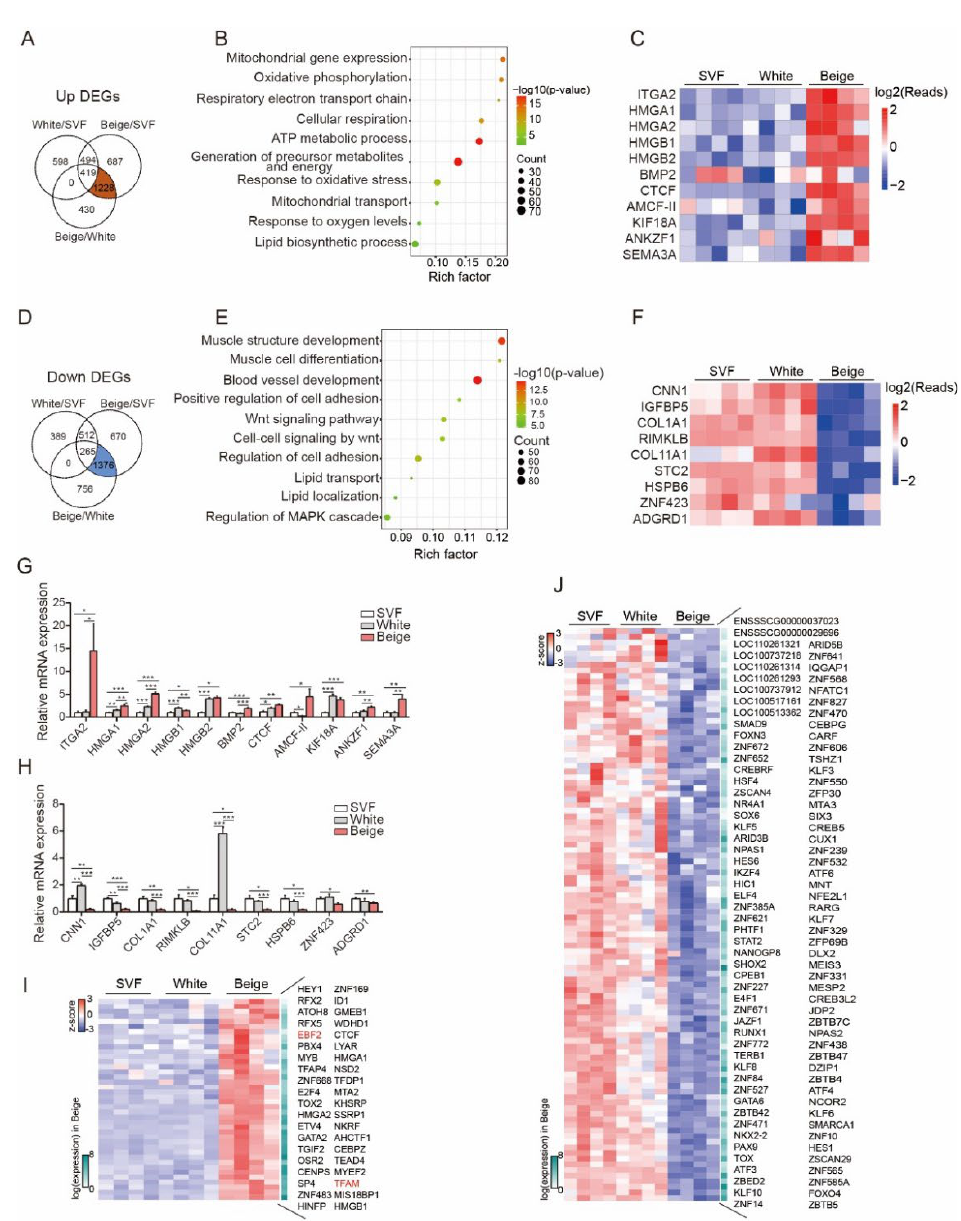
Figure 3. Identification of beige adipogenesis-related candidate genes. ( A , D ). Venn diagram showing the overlapping genes that were specifically and significantly upregulated ( A ) or downregulated ( D ) in the beige/SVF and beige/white groups (FC > 1.5, p < 0.05). Note that a total of 1228 upregulated and 1376 downregulated genes were included based on the criteria. ( B , E ). The above 1228 upregulated and 1376 downregulated genes were subjected to GO analysis, and the dot plot shows the most significantly enriched pathways. The color of the dot represents the p value, and the size of the dot represents the number of differentially expressed transcripts. ( C , F ). Heatmap of the select genes among the 1228 ( C ) and 1376 ( F ) genes. The color scale shows the z score read counts representing the mRNA level of each gene in the blue (low expression)—white–red (high expression) scheme. ( G , H ). The relative expression levels of the significantly upregulated genes among the 1228 genes identified ( G ) and of the significantly downregulated genes among the 1376 genes identified ( H ) in SVF cells and white and beige adipocytes were validated by qPCR ( n = 4–6). ( I , J ). Heatmap of all transcription factors among the 1228 upregulated genes ( I ) and 1376 downregulated genes ( J ). All data are shown as the mean ± SEM. p value was calculated by the unpaired two-tailed Student’s t test. * p < 0.05, ** p < 0.01, and *** p <